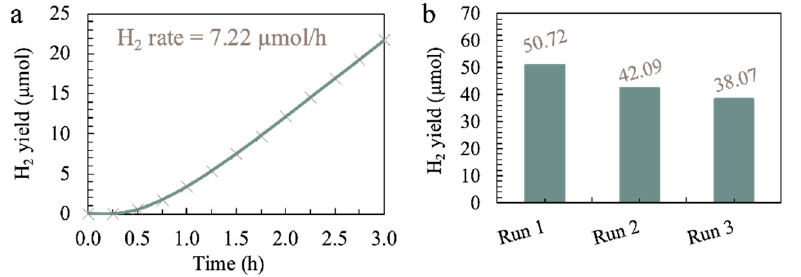
Figure 6. ( a ) Cumulative photocatalytic hydrogen yield over 3 h duration and ( b ) recycling runs of photocatalytic H 2 evolution for ACN under the optimum conditions with 3 wt% Pt under simulated sunlight irradiation for 6 h each cycle.